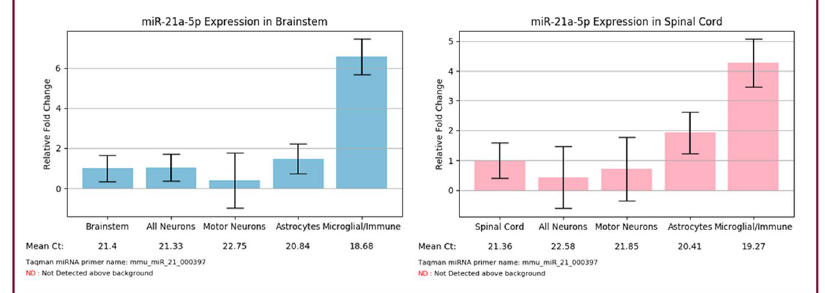
Figure 1. ‘Search by miRNA’ output for miR-21. Expression is consistently enriched in microglial/immune cells within nervous system tissues under physiological conditions (n = 3–4 mice; mean ± SEM). The “Claret” colored frame indicates that miR-21a-5p is broadly conserved among most vertebrate, usually including